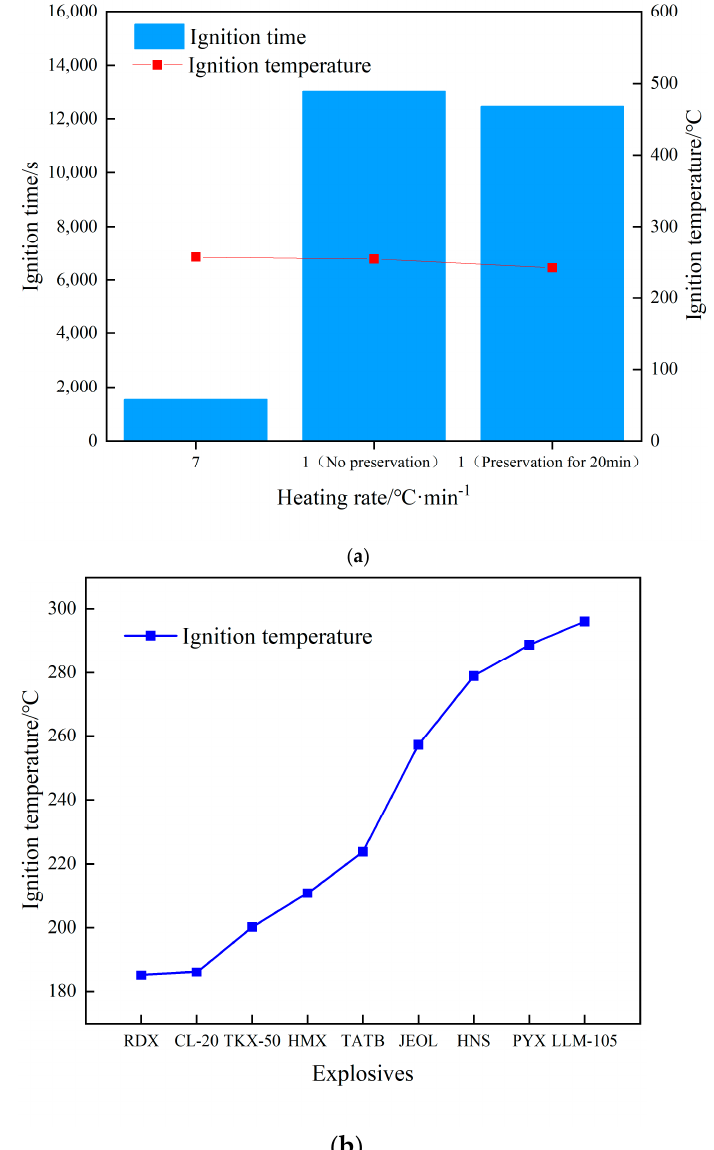
Figure 5. Ignition time/ignition temperature–heating rate curve. ( a ) Ignition time/ignition temperature–heating rate curve. ( b ) Ignition temperature of different explosives.